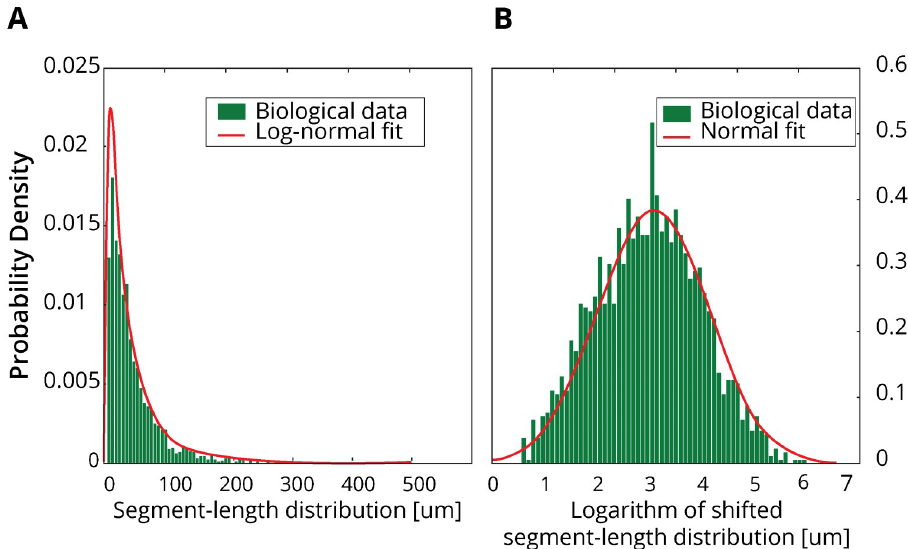
Fig 3. Segment-length distribution of the biological data. (A) Histogram of all 2059 segment-lengths of the dataset and best maximum-likelihood fit. The best fit is achieved by a log-normal distribution. (B) Histogram of the logarithm of the shifted segment-length distribution. The histogram displays now a skewness of only − 0.0636. The Shapiro-Wilk test [43] now fails to reject the null-hypothesis of normality (W 2059 = 0.99, p > 0.16), suggesting that the data follows a shifted log-normal